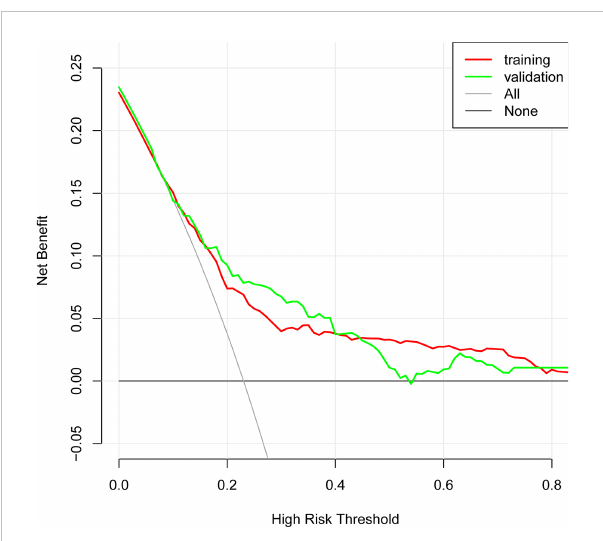
FIGURE 5 The decision curve analysis (DCA) of POP risk nomogram.